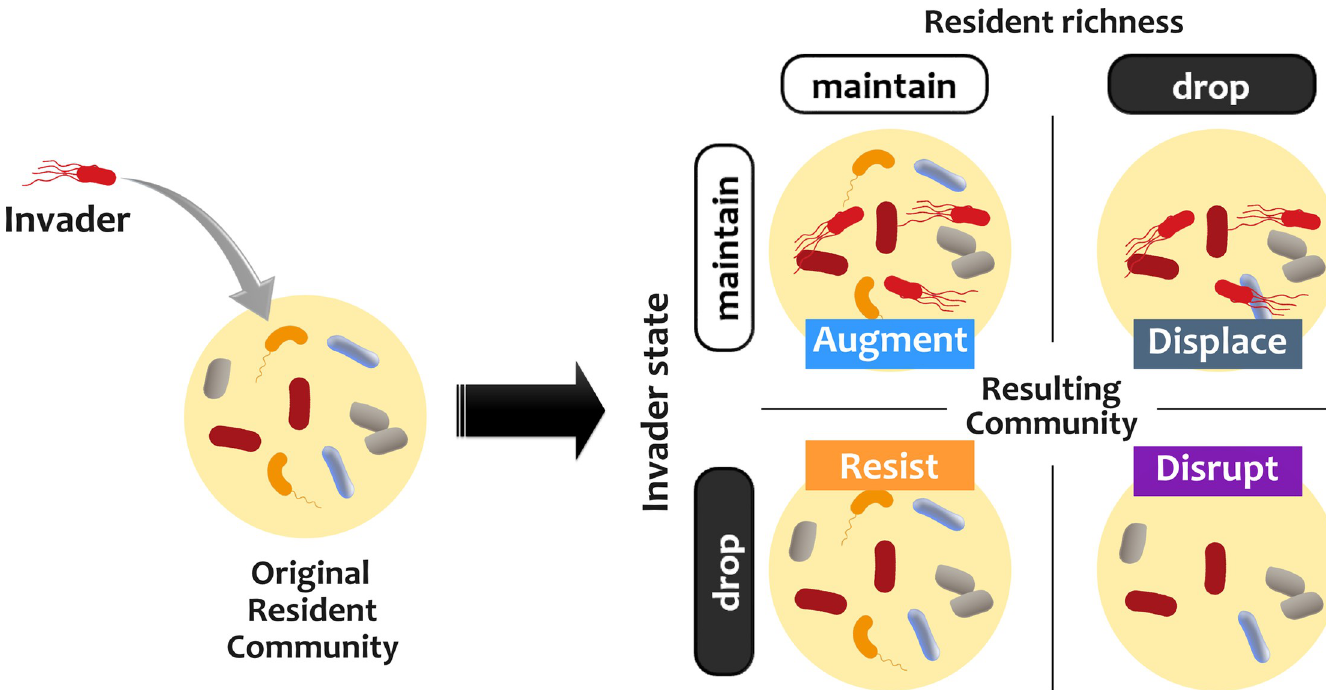
Fig 1. An in silico invasion assay allows us to assess invasion outcomes. In our in silico invasion assay, we first assemble instances of stable resident communities and then assess the outcomes after introducing an invader. Based on whether the invader persists or goes extinct and whether the resident community maintains or decreases in richness, we categorize the outcomes into four groups: ‘Resistance’ (invader extinct, resident richness maintained), ‘Augmentation’ (invader maintained, resident richness maintained), ‘Disruption’ (invader extinct, resident richness drops), and ‘Displacement’ (invader maintained, resident richness